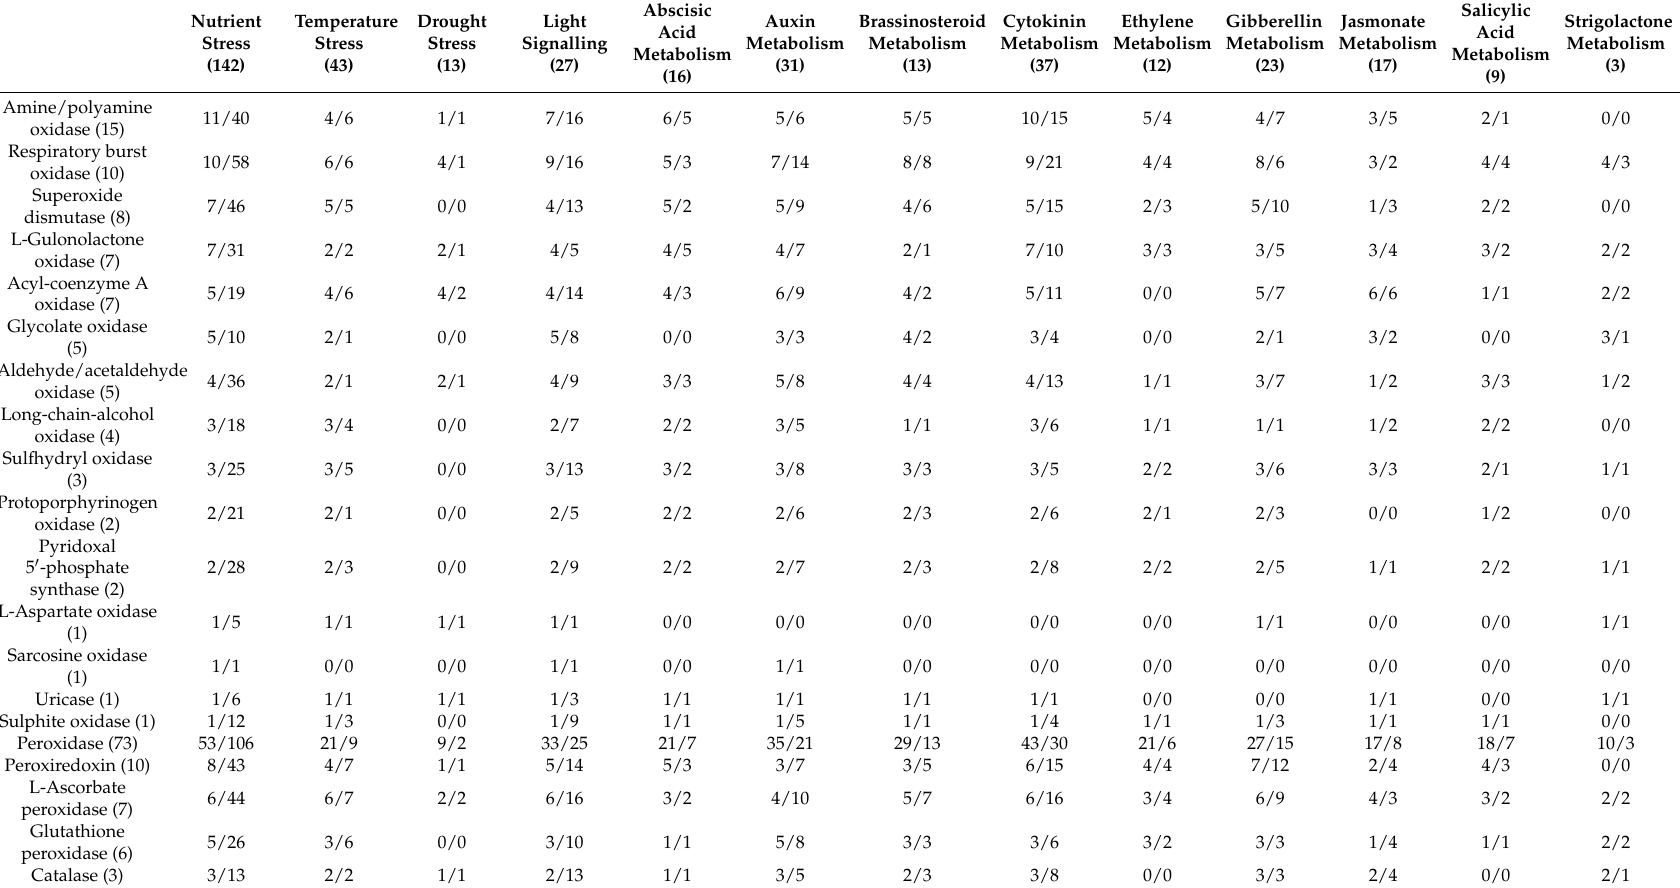
Table 2. Hydrogen peroxide metabolism genes have expression patterns similar to those of genes related to light signalling, nutrient status, temperature stress, drought stress and hormonal metabolism. Based on average gene expression profiles in stress-related experiments (ThaleMine [11]) and reference stress-related genes [247]. Numbers indicate the number of analysed genes (numbers in brackets) and the number of detected co-expressed genes (hydrogen peroxide metabolism/candidate signalling and metabolism genes). See Supplementary Materials for the full list of co-expressed